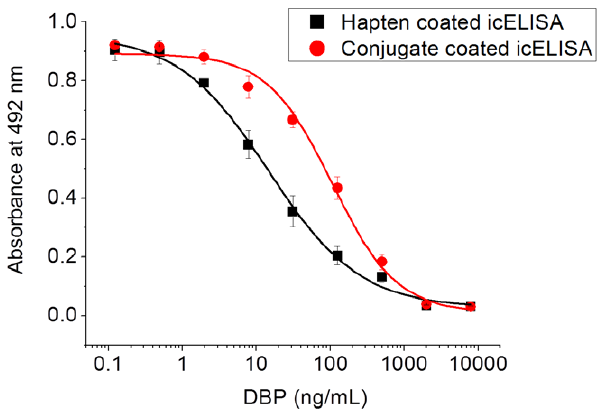
Figure 5. Representative icELISA standard curves for DBP. Each point represents the mean of 6 SD of three replicates (one plate on three different days). The standard curve was calculated according to the 4-parameter equation y =( A 2 D )/[1 + ( x / C ) B )] + D with the following values: for hapten coated icELISA, A =0.956, B =0.705, C =14.6 ng/mL, D =0.027, R 2 =0.9985; for conjugate coated icELISA, A =0.892, B =0.994, C =106 ng/mL, D =0.0094, R 2 =0.9976.